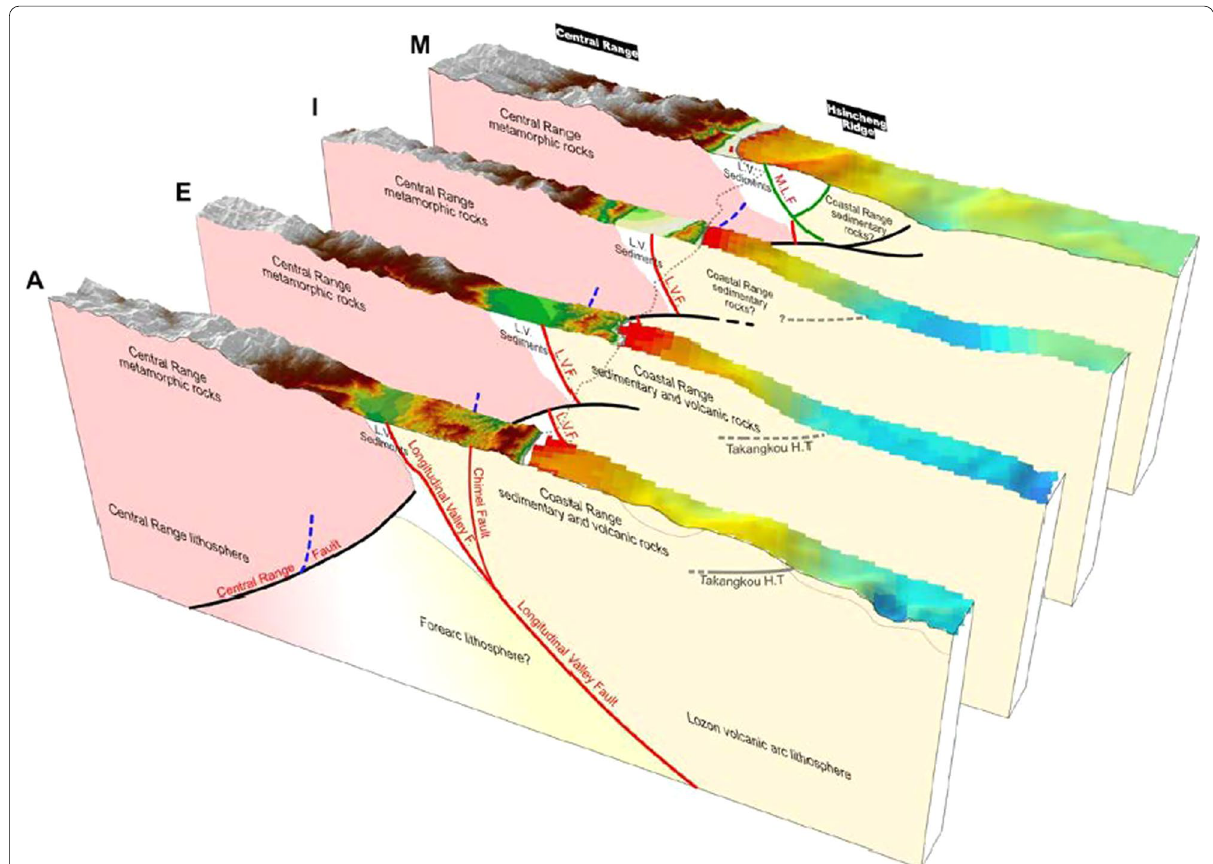
Fig. 9 A schematic structural model of the northern Longitudinal Valley showing the truncation relationship between the active Central Range Fault system and the active Longitudinal Valley Fault system. Black lines are the simplified seismogenic fault of the Central Range Fault system, with blue sub‑vertical splay faults developed within the Central Range blocks. The Red lines are faults within the Longitudinal Valley Fault system, including the Longitudinal Valley Fault (LVF) and the Chimei Fault. Gray lines represent the location and approximate geometry of the Takangkou‑Height Thrust from Hsieh et al. (2020), while the Green lines show the Milun fault (M.L.F.) and its associated faults offshore